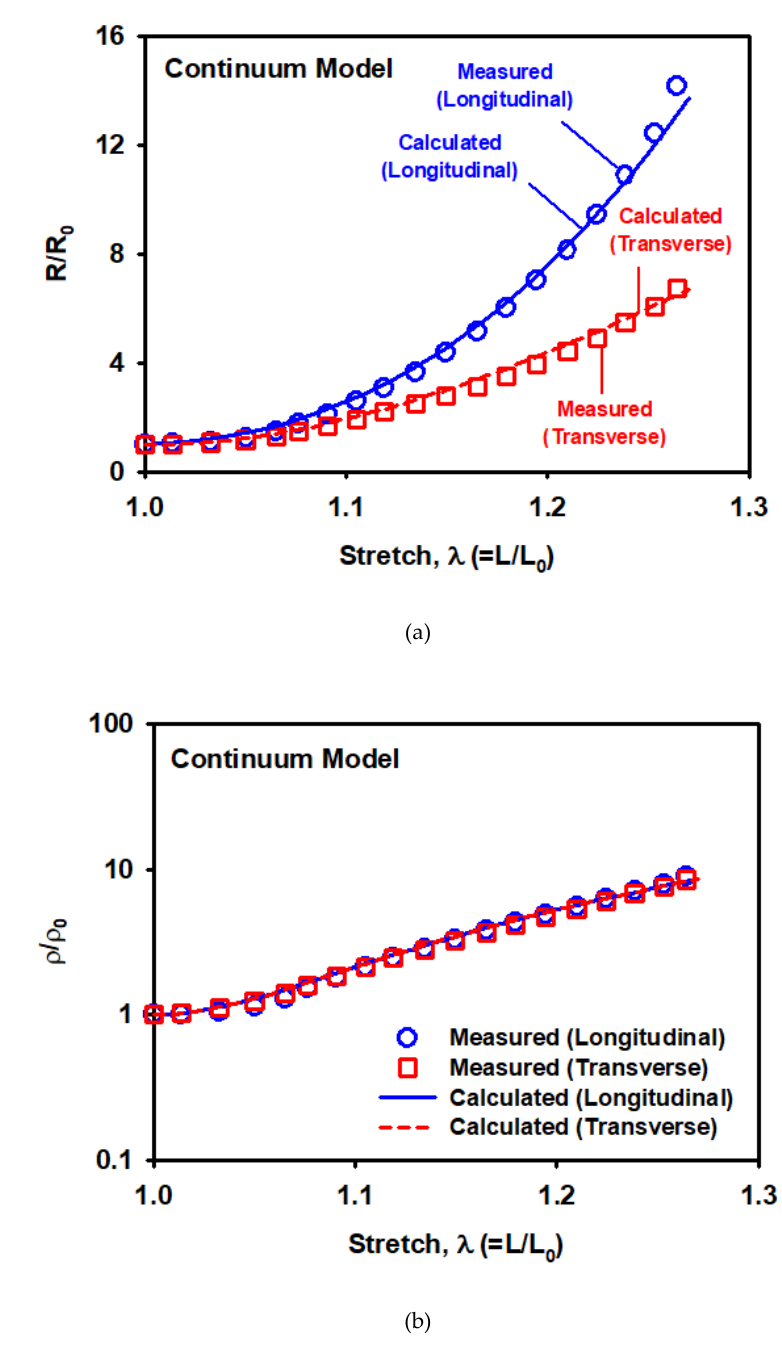
Figure 22. ( a ) Normalized resistance and ( b ) normalized resistivity predicted by the continuum resistivity